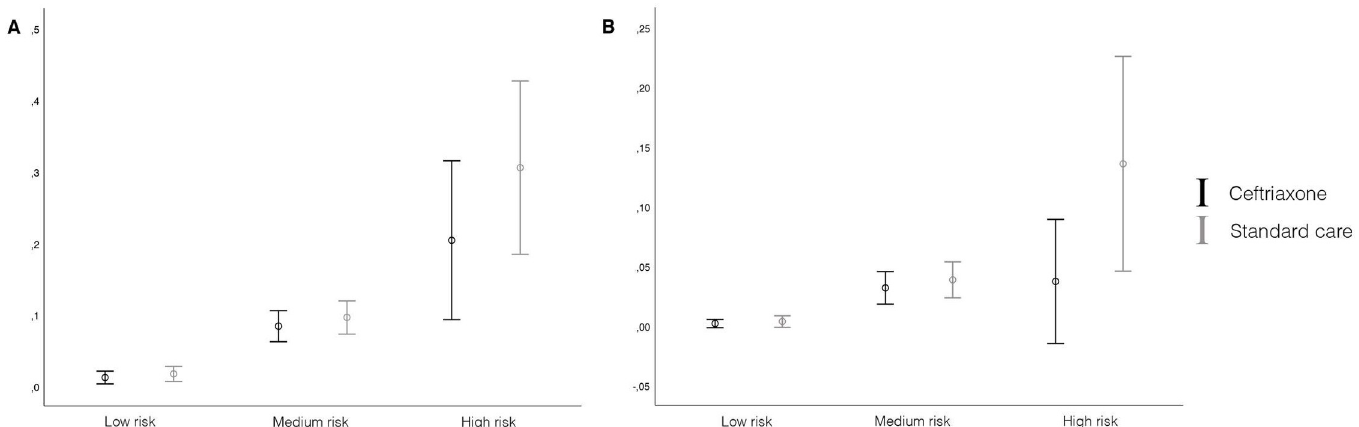
Fig 1. 2-panel figure showing pneumonia rate as judged by the physician (panel A) and by the adjudication panel (panel B) per treatment stratum for low, medium and high ISAN-score.